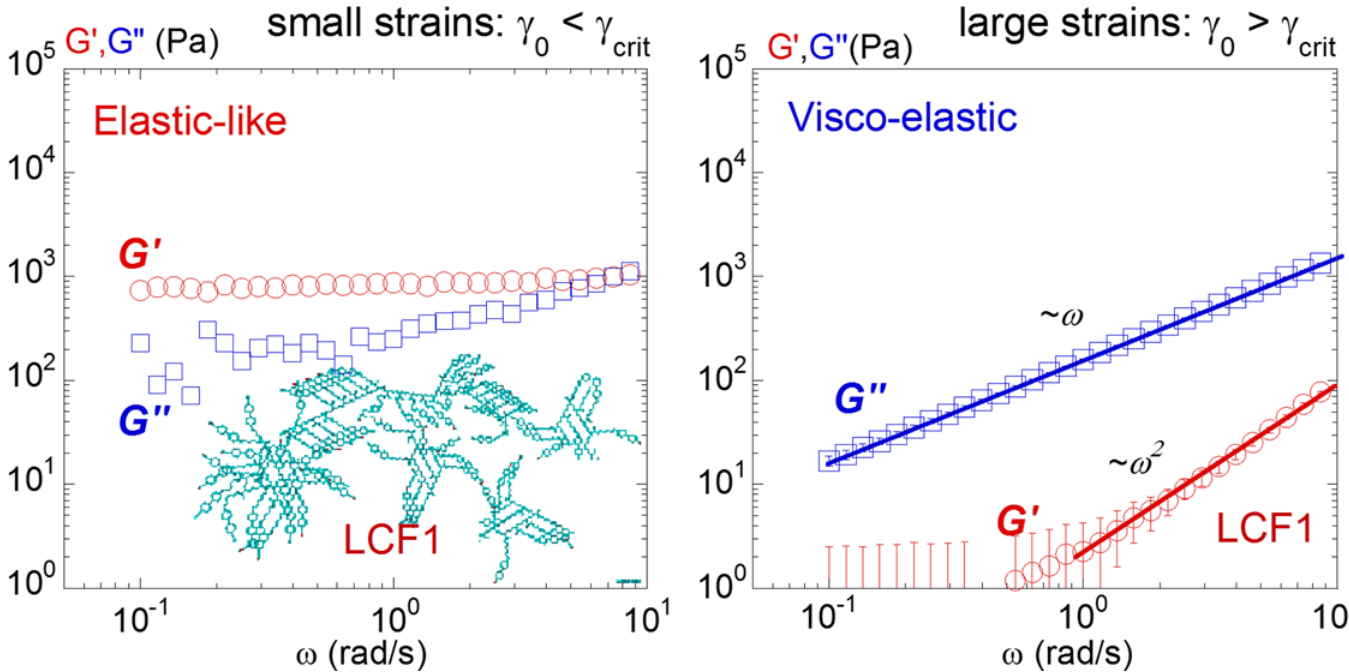
Fig 6. Elastic-like versus liquid-like relaxation spectra of LCF2: (left) At small strains ( γ 0 = 0.5%) the elastic modulus G ’ (red circles, (cid:5) ) and the viscous modulus G ” (blue squares, □ ) are independent of the frequency. G ’ is the dominating modulus indicating an elastic-like behaviour. (right) At large strains ( γ 0 = 300%) the viscous modulus shows a conventional behaviour (G ” = ω . η ) and reveals a liquid-like behaviour. Measurements carried out at +25°C above the isotropic-smectic transition, gap thickness:170 μ m.